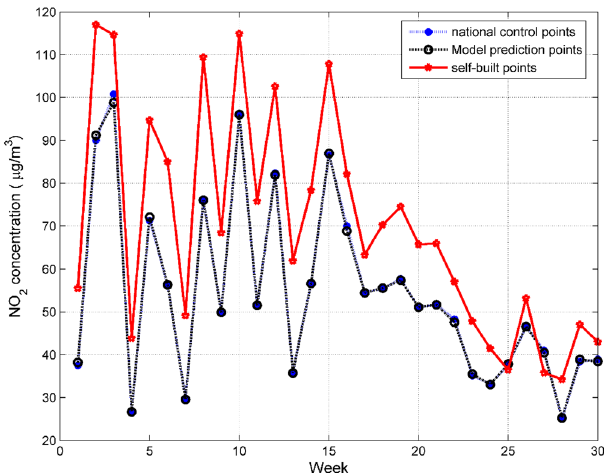
Figure 10. Comparison of the weekly average concentration of NO 2 between national control points, PCR– SVR–ARMA model calibration points and self-built points.